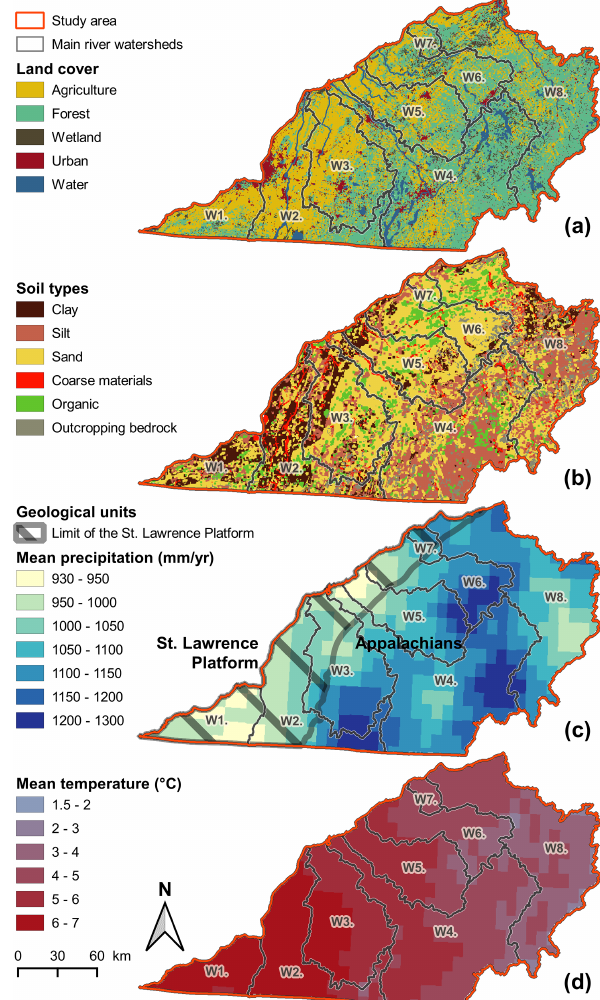
Figure 2. (a) Land cover (reclassified from Bissonnette et al., 2016), (b) soil types (IRDA, 2008), (c) mean precipitation (1961–2017) as well as the areas of the St. Lawrence Platform (hatched) and the Appalachians, and (d) mean temperature (1961–2017) (Bergeron, 2016).